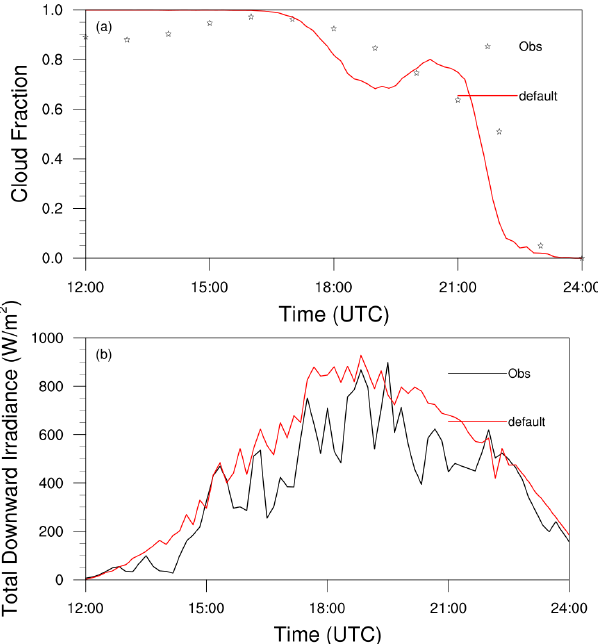
Figure 4. Time series of (a) domain-averaged cloud fraction and (b) total downward irradiance at the central point from the observa- tion and the default experiment in the stratocumulus case.